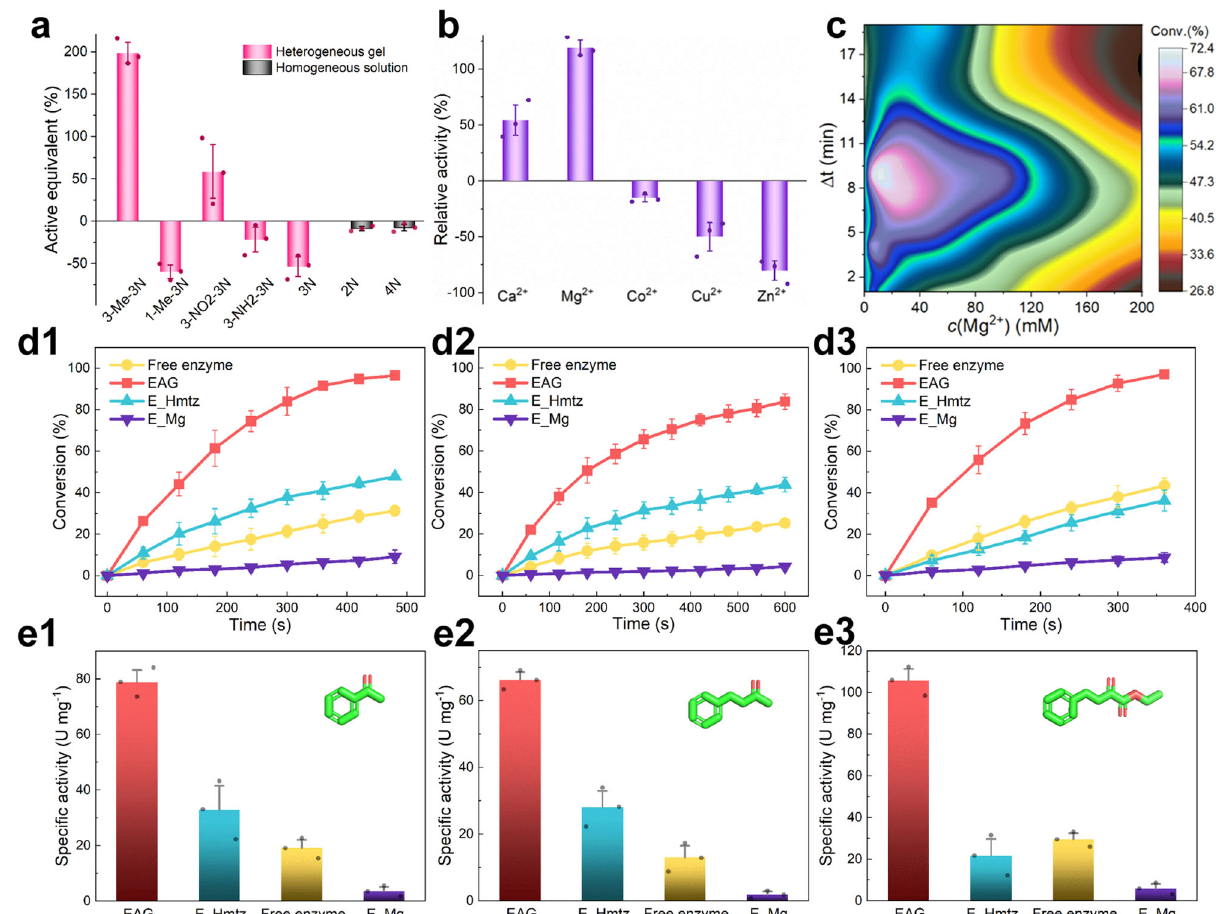
Fig.3|CatalyticperformanceofEAGfortheasymmetricreductionofprochiral aryl ketones. a Screening of polyazoles based on the active equivalent of the formed gel (red bars) or solution (black bars) compared to the catalytic activity of the free enzyme utilized for gelation. 3-Me-3N: Hmtz. 1-Me-3N: 1-methyl-1,2,4-tria- zole (without N – H). 3-NO2-3N: 3-nitro-1,2,4-triazole. 3-NH2-3N: 3-amino-1,2,4-tria- zole.3N:1,2,4-triazole.2N:imidazole.4N:tetrazole. b Screeningofmetalionsbased on the catalytic activity of the formed gel relative to that of the enzyme without metalions(0%). c EffectsoftheMg 2+ concentration( c (Mg 2+